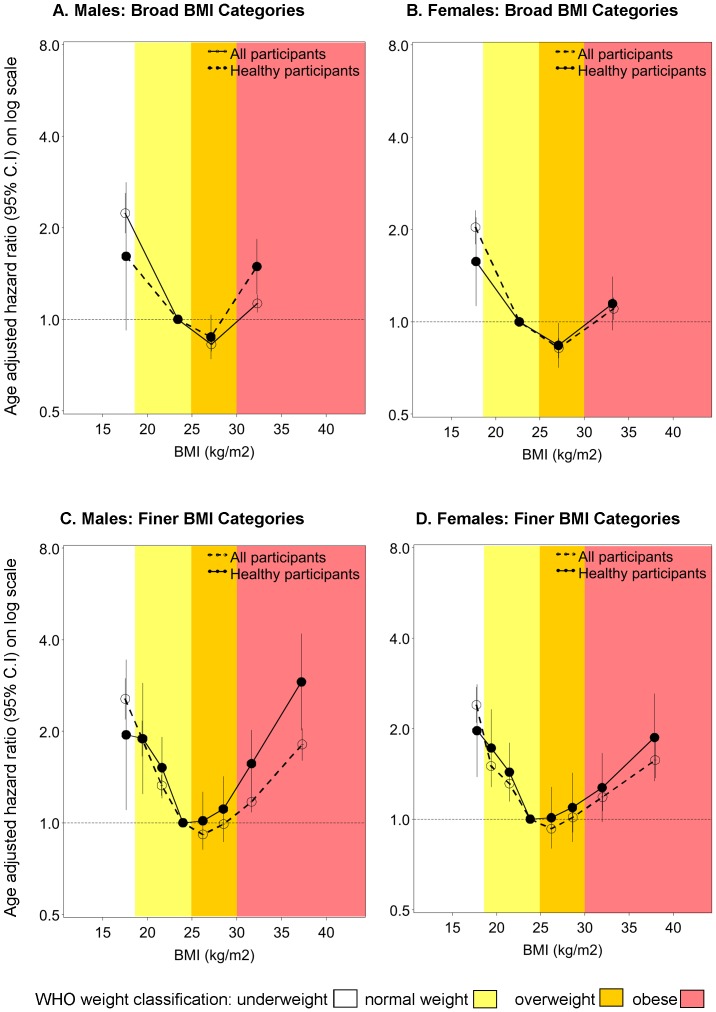
Hazard ratio estimates for all-cause mortality by sex and differing BMI categories.Hazard ratios (HRs), adjusted for age as the underlying time variable, are plotted on log-scale at median body mass index (BMI) for the categories: broad categorisation 15–18.49, 18.5–24.99 (reference), 25–29.99, 30–50 kg/m2; finer categorisation 15–18.49, 18.5–19.99, 20–22.49, 22.5–24.99 (reference), 25–27.49, 27.5–29.99, 30–34.99, 35–50 kg/m2. 95% CIs are indicated by vertical lines. The healthy participants analyses excludes those who ever smoked at baseline, those with a history of cardiovascular disease at baseline (defined as self-reported heart disease, stroke or blood clot on the baseline questionnaire) and those with a history of cancer at baseline (defined as self-reported history of cancer other than melanoma and skin cancer on the baseline questionnaire), and excludes the first 2 years of follow-up.